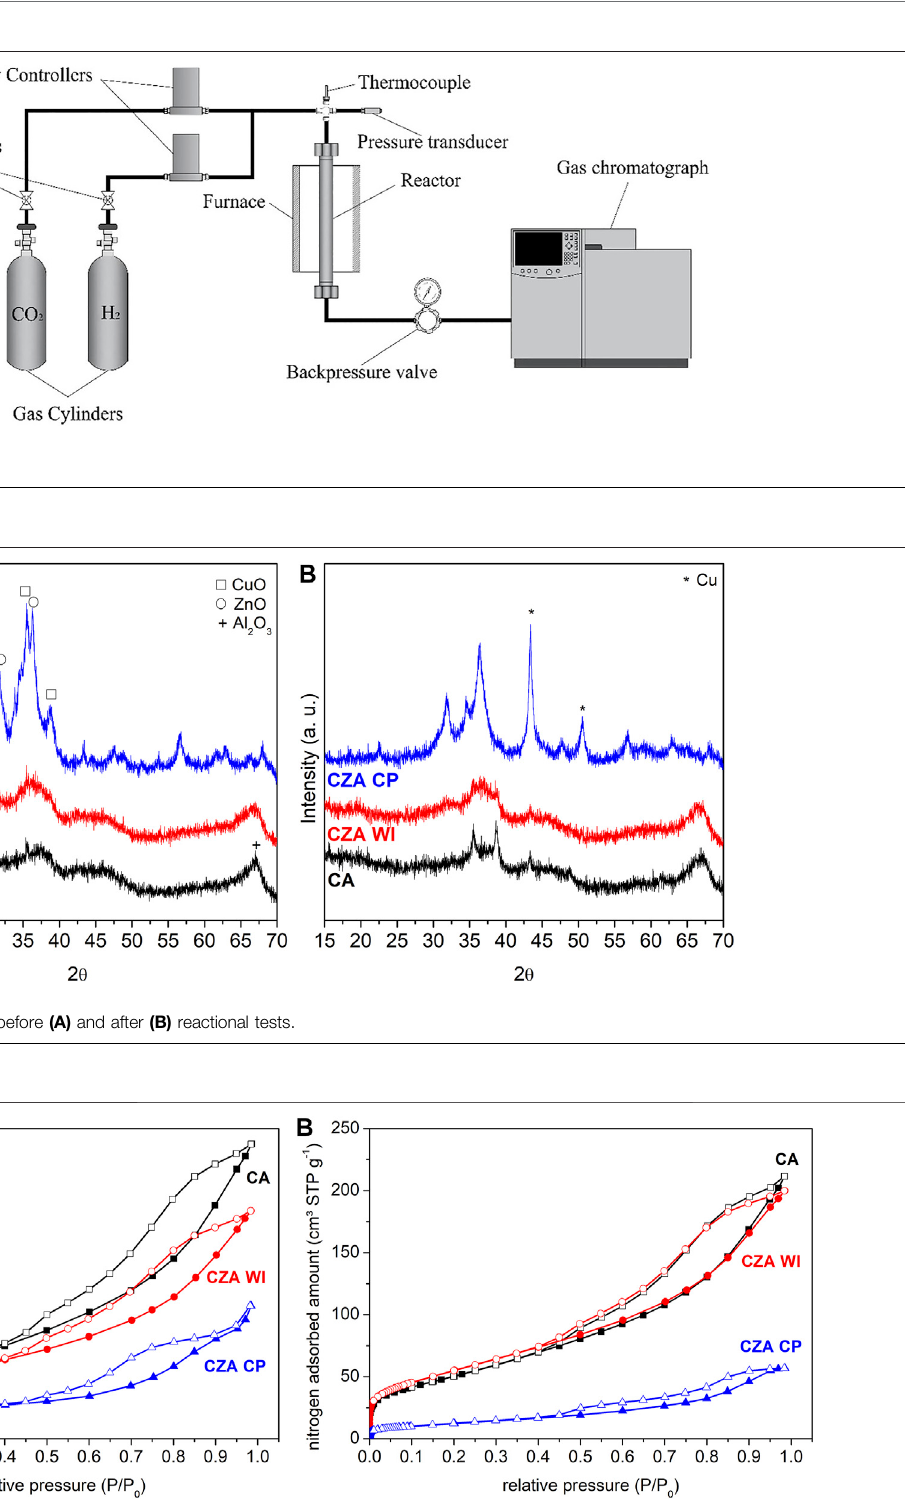
Frontiers in Chemistry |